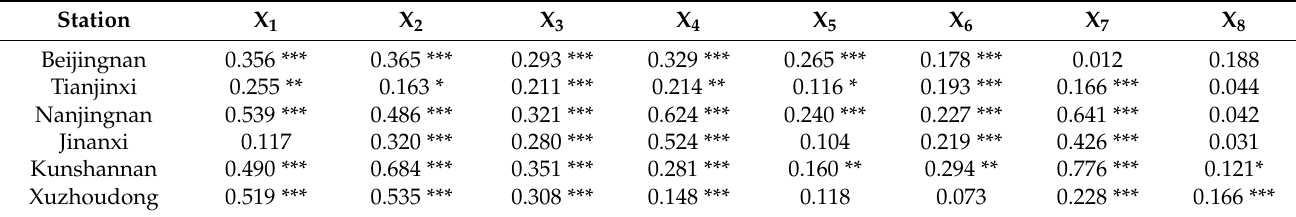
Table 4. Detection results of influencing factors in station